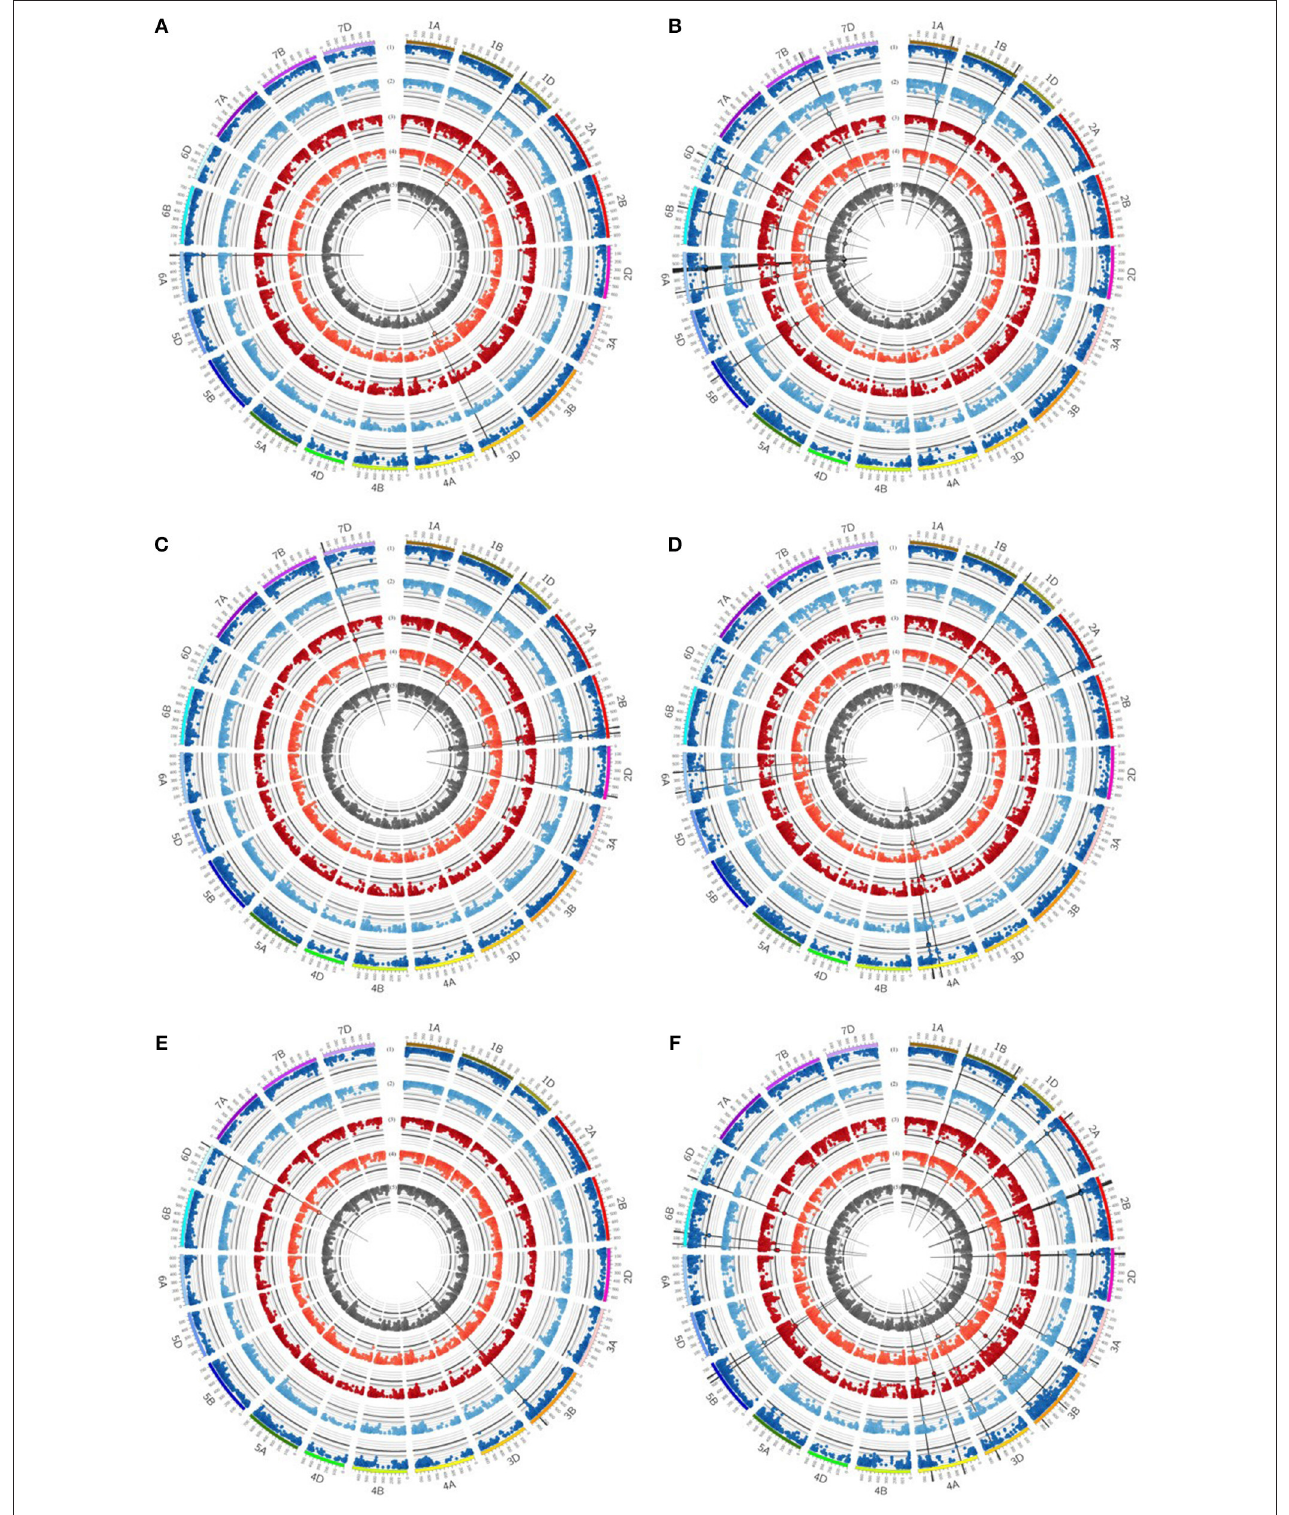
FIGURE 4 | Circos plot for (A) grain yield (GY), (B) straw yield (SY), (C) number of grains per ear (GN), (D) biomass yield (BM), (E) thousand grain yield (TGW) and (F) harvest index (HI). Dark blue (1) and light blue (2) circles represent results of genome-wide association studies for traits under well watered conditions in the